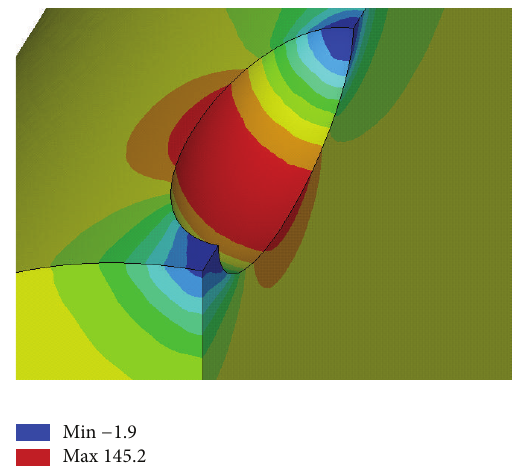
Figure 11: Stress distribution near the pit with 𝑑 = 1 mm.